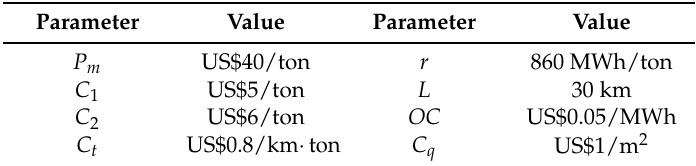
Table 1. Parameter values from field